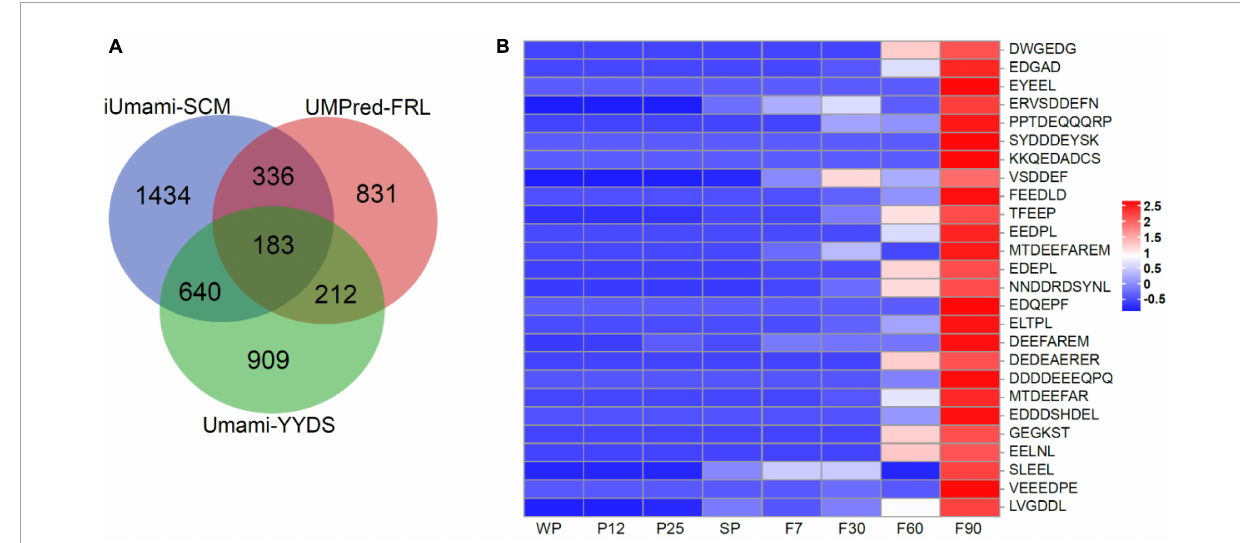
FIGURE3 Umami peptides in sufu. (A) Venn analysis for the identification of umami peptides. (B) Heatmap analysis of umami peptides during fermentation of sufu.